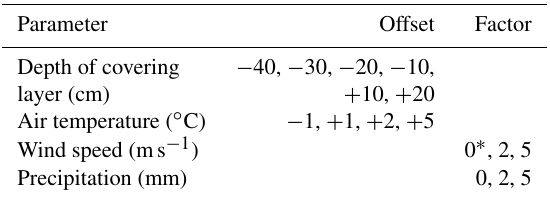
Table 3. Parameters and settings (offset or factor) applied to the sensitivity